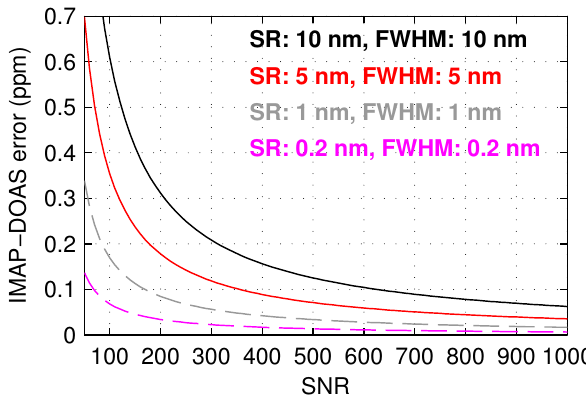
Fig. 6. Estimated IMAP-DOAS retrieval errors (ppm CH 4 ) for four hypothetical sensors, each with the spectral resolution (SR) equal to the FWHM. Errors are relative to lowest atmospheric layer (height up to 1.04km) and decline with increased signal-to-noise ratio (SNR).